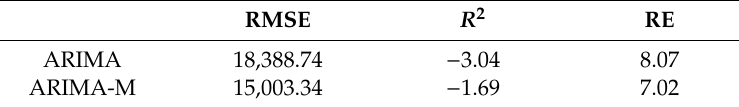
Table 11. Prediction error of test set for monitoring point